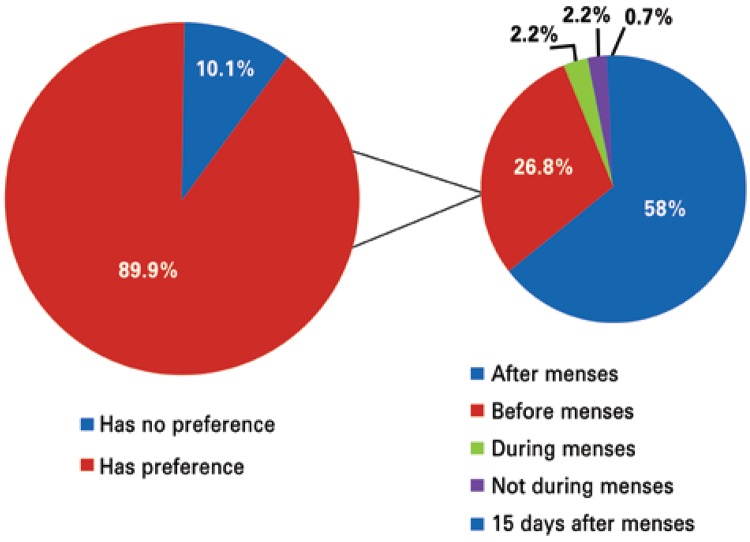
Period of the menstrual cycle in which the athlete prefers to compete